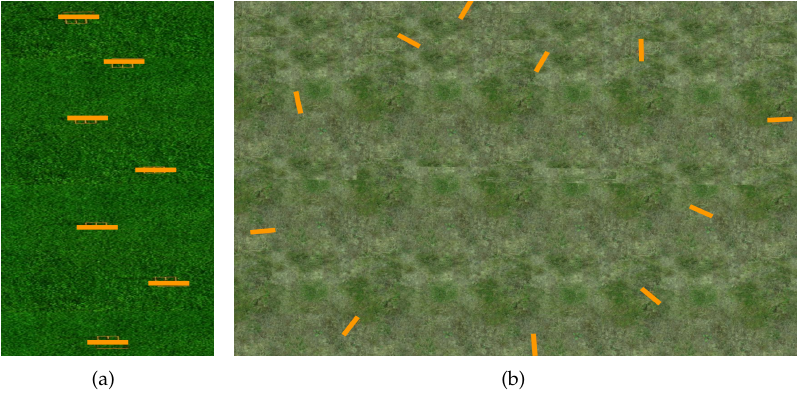
Figure 4. Racetracks in Gazebo for data collection. ( a ) This racetrack is composed of 7 gates 2 m in height. The track spans over a surface of 53.5 m × 9.6 m, and space in between gates from 10 m to 12 m. ( b ) A second racetrack composed of 3 gates 3.5 m in height, 4 gates 2 m in height and 4 gates 1.2 m in height, randomly positioned. The track spans over a surface of 72 m × 81 m, and space in between gates from 2 m to 12 m.